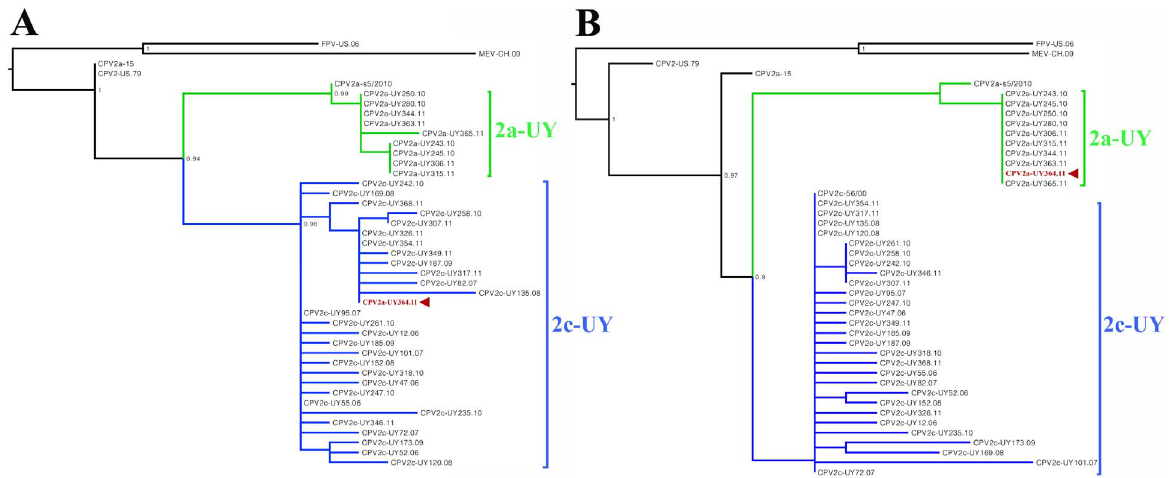
Figure 2. Phylogenetic incongruence analysis. Phylogenetic reconstructions were performed with non-recombinant fragments of the 4269-bp CPV coding region containing nt 1–2500 (A), and nt 2501–4269 (B). The 364-rec strain (arrowhead) associates with both the CPV-2c (A) and CPV-2a (B) clades. 2a-UY: Uruguayan CPV-2a clade; 2c-UY: Uruguayan CPV-2c clade; FPV-US.06: feline panleukopenia virus (EU659115); MEV-CH.09: mink enteritis virus (FJ592174); CPV2-US.79: Canine parvovirus type 2 (M38245); CPV2a-15 United States 2a isolate (M24003); CPV2a-s5/2010 Chinese 2a isolate (KF638400.1). CPV2c-56/00 Italian 2c isolate. CH: China; US: United States; UY: Uruguay.